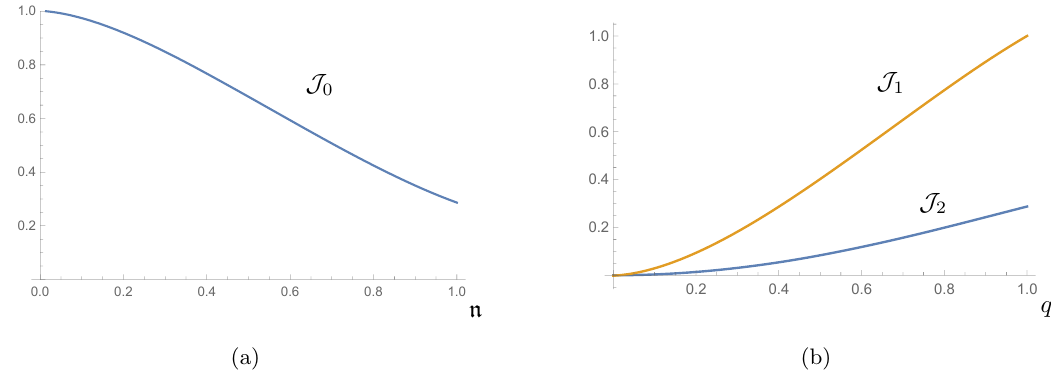
Figure 3 . On the left hand side a plot of J 0 , which yields the partition function for the 3-pole solutions via (4.29). On the right hand side similar plots for J 1 and J 2 , which yield the partition functions of the 4-pole solutions via